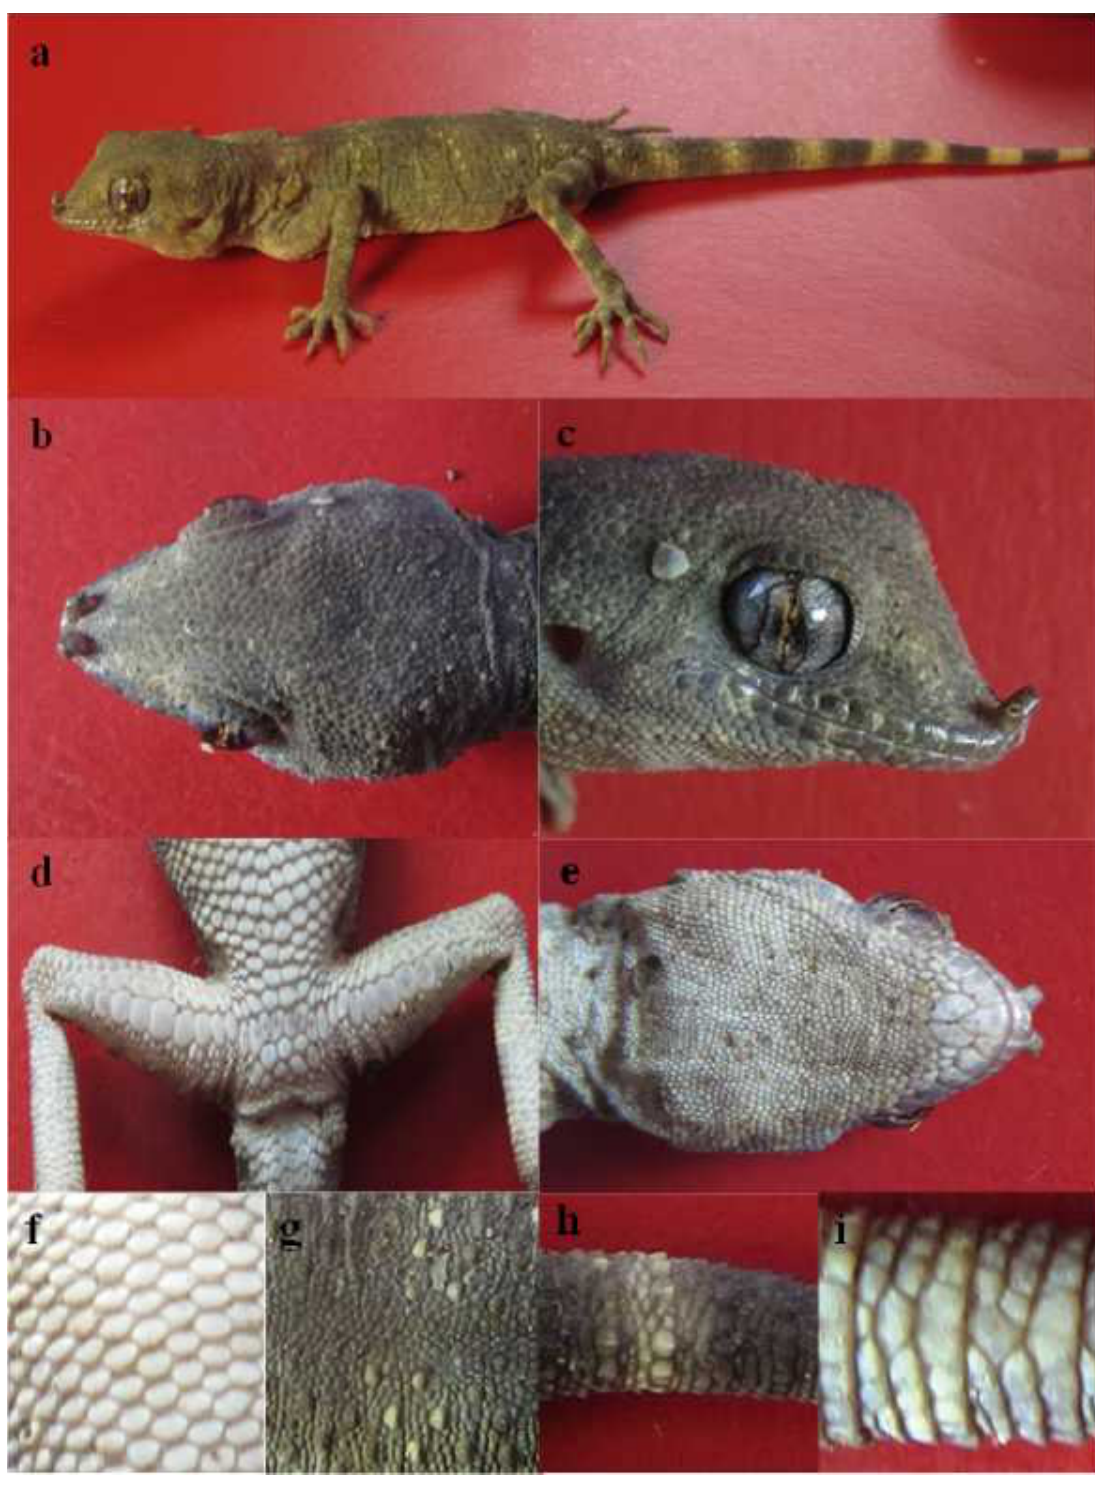
F IGURE 2. Rhinogecko misonnei : (a) complete view; (b) Dorsal view of head; (c) Lateral view of head; (d) Enlarged scales on lower surface of thigh; (e) ventral view of head; (f) ventral scales; (g) dorsal scales; (h) dorsal view of tail scales; (i) ventral view of tail